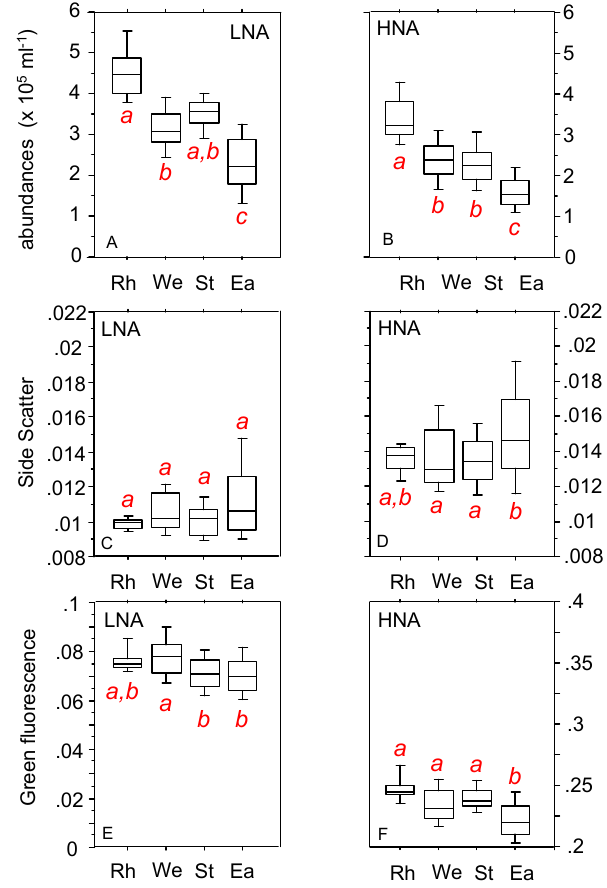
Fig. 6. Box plots showing distribution of ( A, B) : abundances, ( C, D) : side scatter and ( E, F) : green fluorescence of subgroups LNA and HNA in the “surface” layers according a regional distri- bution: “Rh” (stations 27, 26, 25), “We” (stations 24, 23, A, 22, 21, 20, 19), “St” (Stations 18, 17, 16, 15, 14) and “Ea” (stations 13, 12, B, 1, 2, 3, 4, 5, 6, 7, 8, 9, 10, C). Groups connected by the same letter (in italics and in red) are not significantly different at the 0.01 probability level.